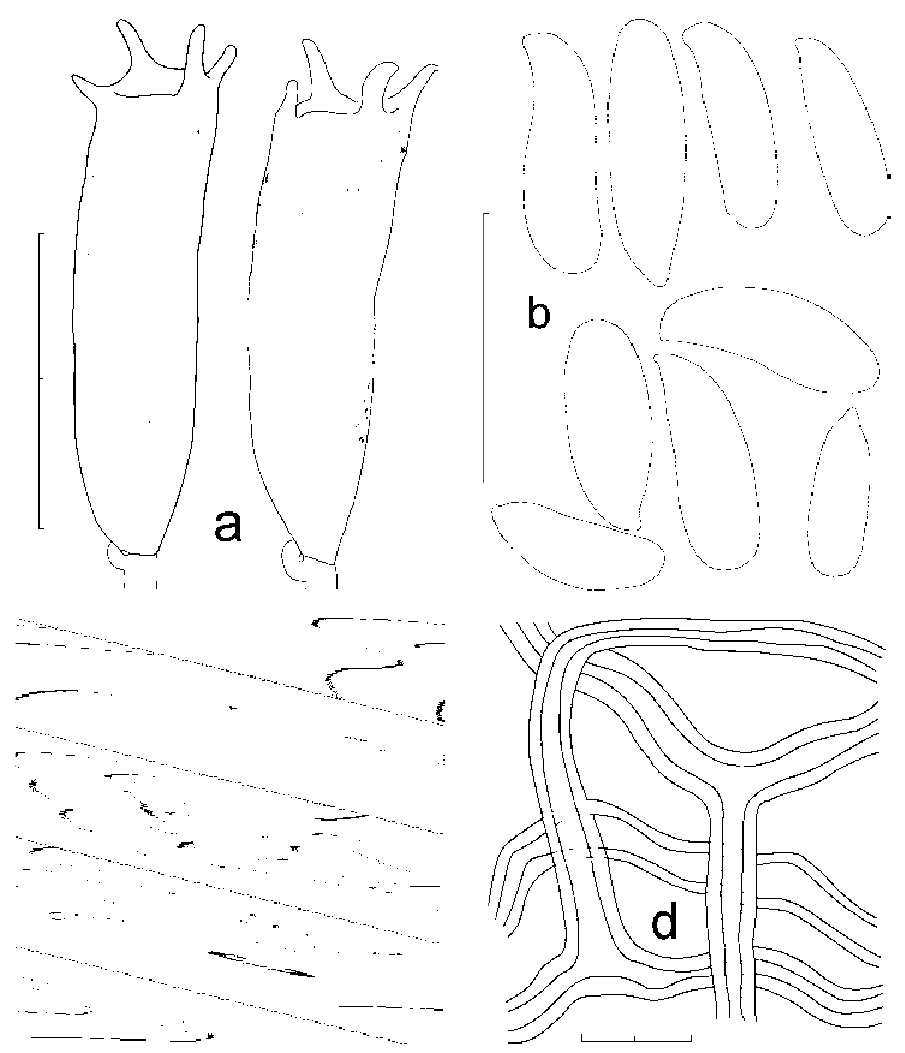
Fig. 1. Polyporus rhizophilus : a – basidia; b – spores; c – generative hyphae; d – skeletal hyphae (kTc 3296). scale bar = 10